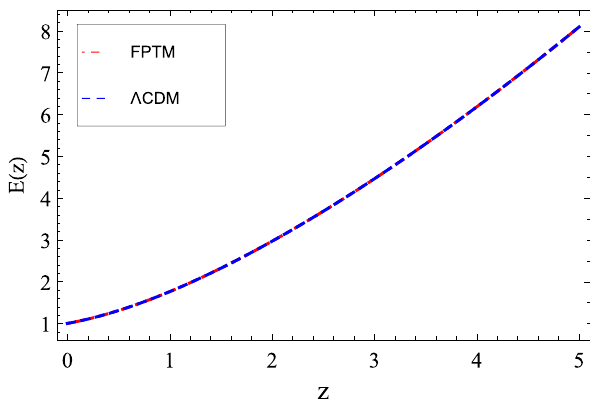
Fig. 11 The variation of the Hubble dimensionless parameter E ( z ) versus z for the Λ CDM and FPTM models